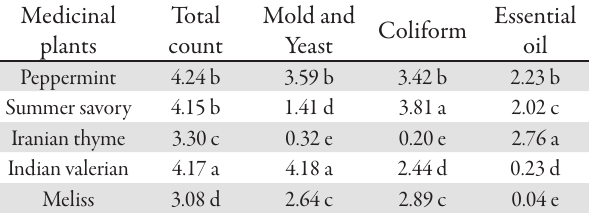
Tab. 3. Mean squares of microbial load of medicinal plants Medicinal